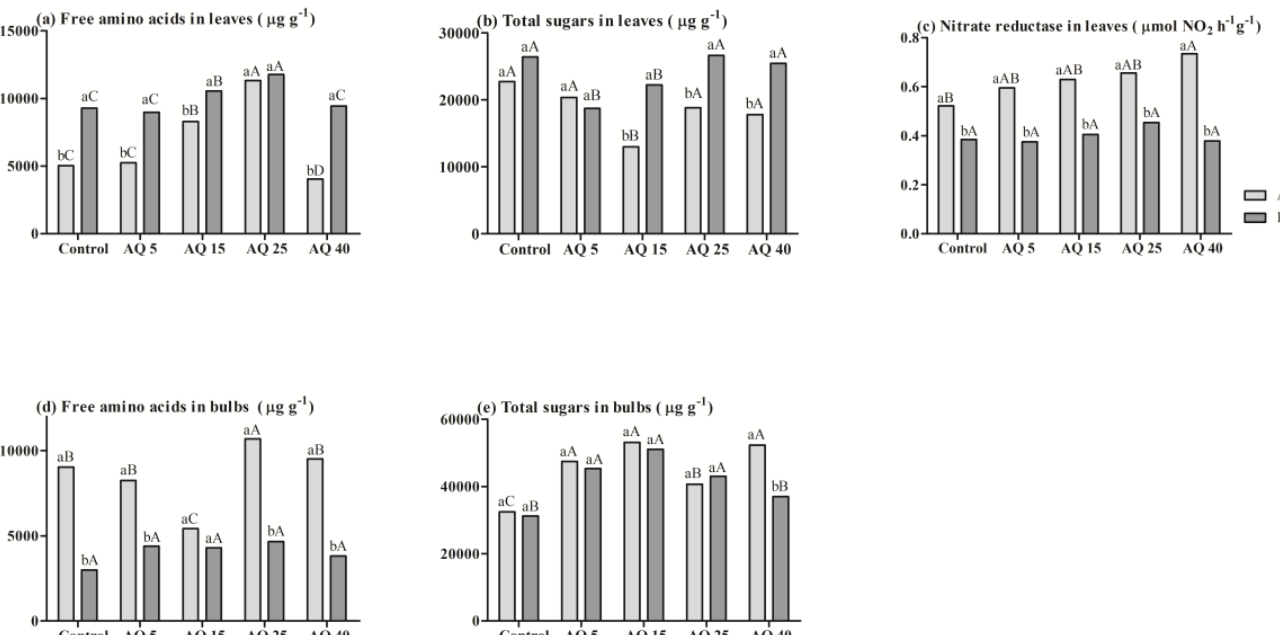
Figure 5. Free amino acids in leaves ( a ), total sugars in leaves ( b ), enzyme nitrate reductase activity in leaves ( c ), free amino acids in bulbs ( d ), total sugars in bulbs ( e ) in onion cultivars at 135 DAT submitted to foliar applications of biomass suspensions of the microalgae A. quadricellulare at different concentrations. Treatments: 0 g L − 1 (control); 0.05 g L − 1 (AQ 5); 0.15 g L − 1 (AQ 15); 0.25 g L − 1 (AQ 25); 0.4 g L − 1 (AQ 40). Lower-case letters in the column: cultivars; upper-case letters in the column: treatments. Means followed by the same letter in the same column do not differ statistically ( p < 0.05) according to Tukey’s test ( n =